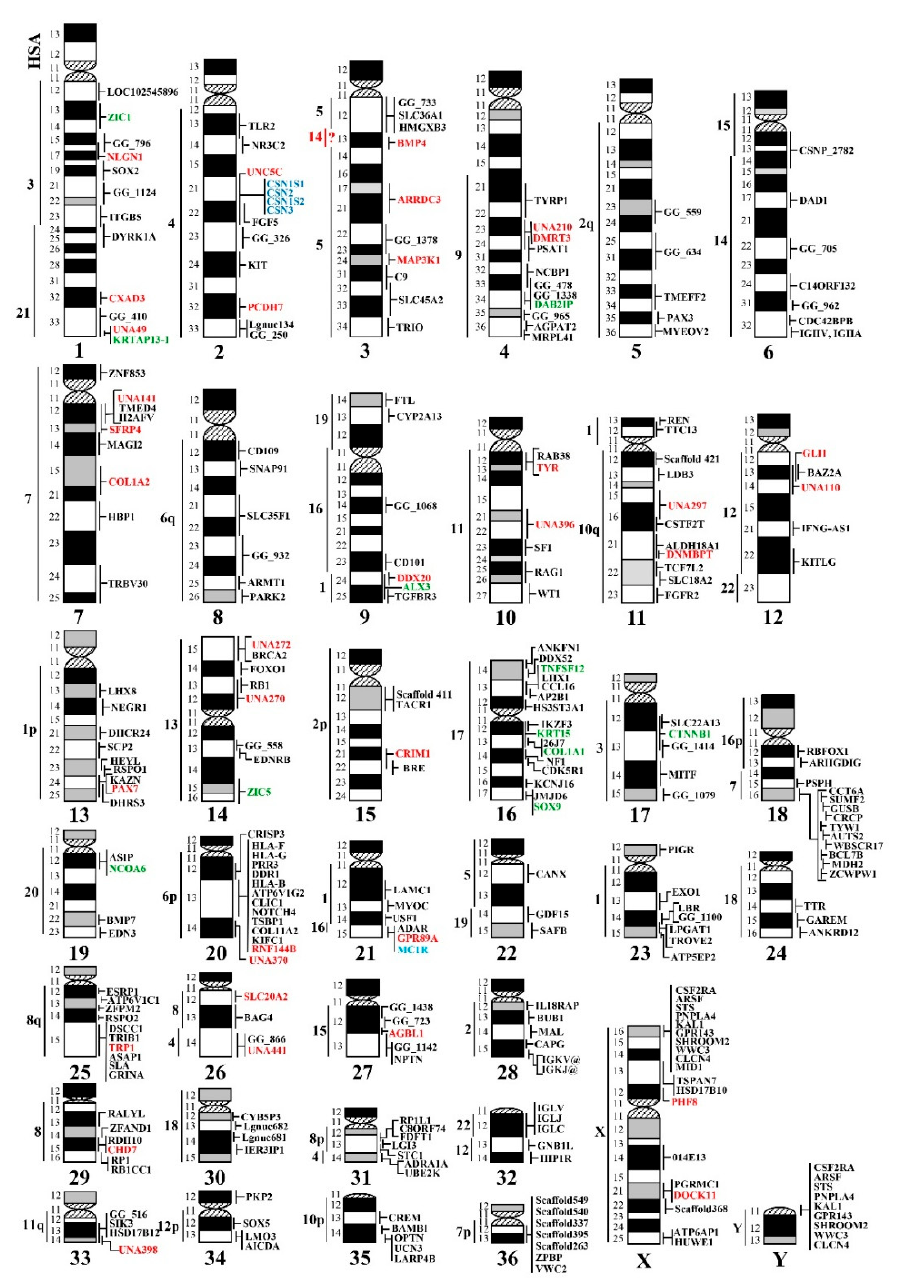
Figure 2. Summary status of the alpaca / camelid whole genome cytogenetic map with 281 markers. Markers in red font were mapped in this study; black font—original WG map by Avila et al. (2014a); green font—mapped by Mendoza et al. (2019); dark blue font—mapped by Pauciullo et al. (2019); light blue font—mapped by Alshanbari et al.